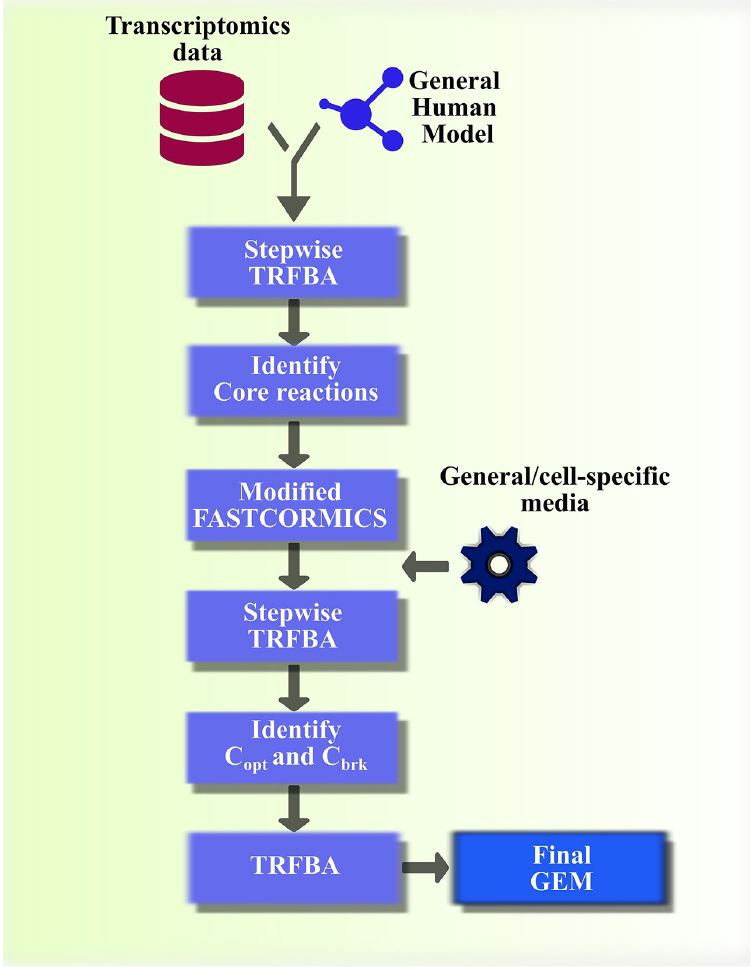
Fig 12. TRFBA-CORE workflow. TRFBA-CORE employs the stepwise version of TRFBA to identify a set of growth- associated reactions, build cell-specific models using modified FASTCORMICS, and generate tuned cell-specific